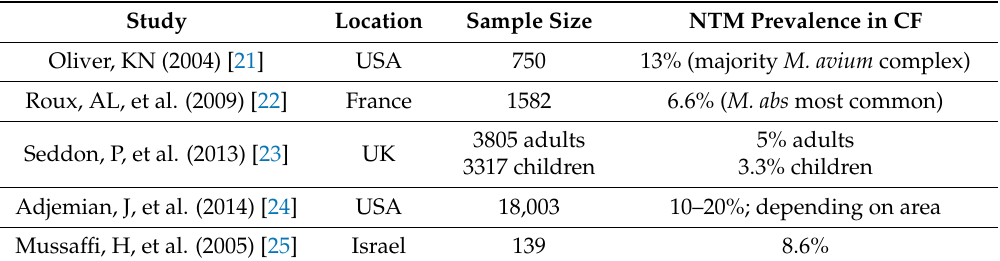
Table 1. Prevalence of non-tuberculous mycobacterial lung disease in cystic fibrosis patients in differing geographical areas between 2004 and 2014. CF: cystic fibrosis.